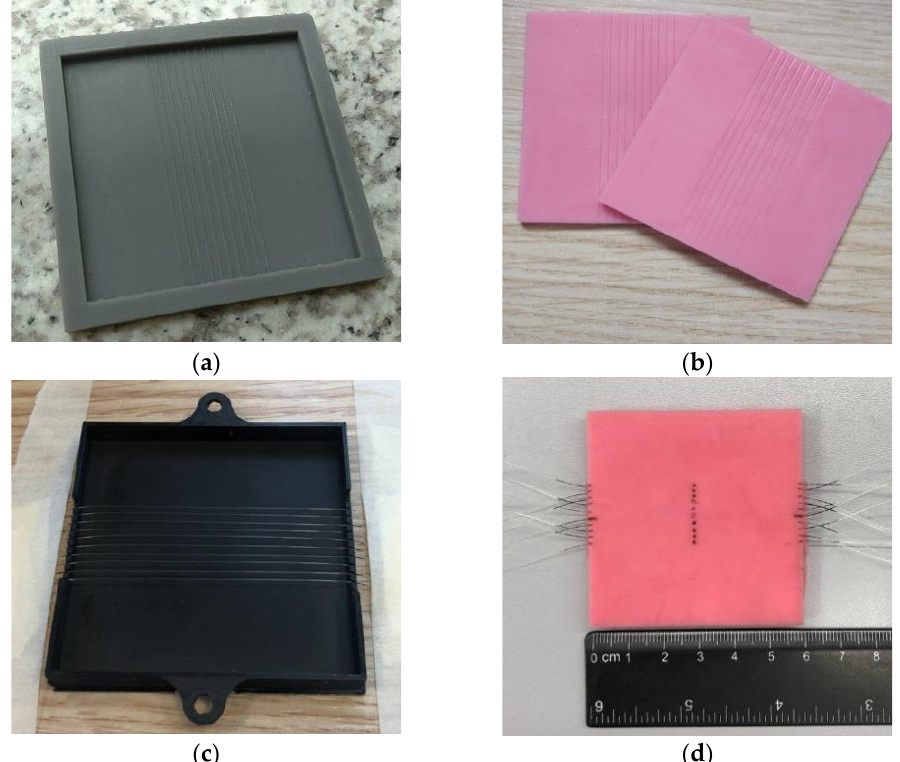
Figure 2. Preparation of the silicone with parallel grooves: ( a ) Grey V4 form for mold; ( b ) two prepared silicones; preparation of the embedded SMF in silicone: ( c ) the mold with fixed fiber lines on the working table; ( d ) embedded silicone prototype.